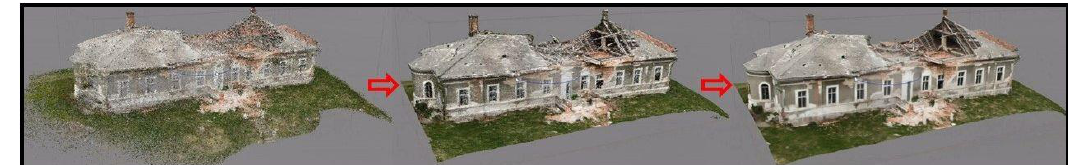
Figure 7. 3D model reconstruction from early stages of point cloud.